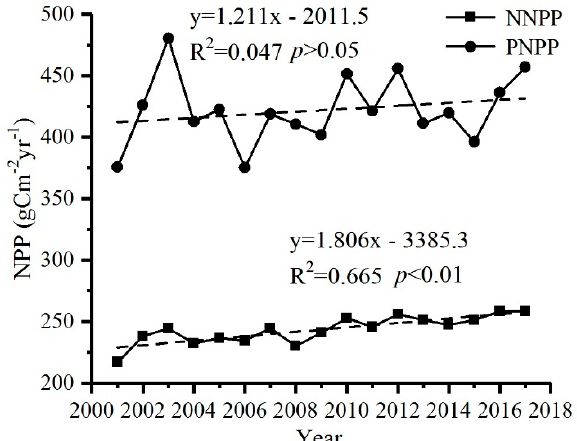
Figure 8. Spatial distribution of annual mean NNPP and PNPP during 2001–2017.